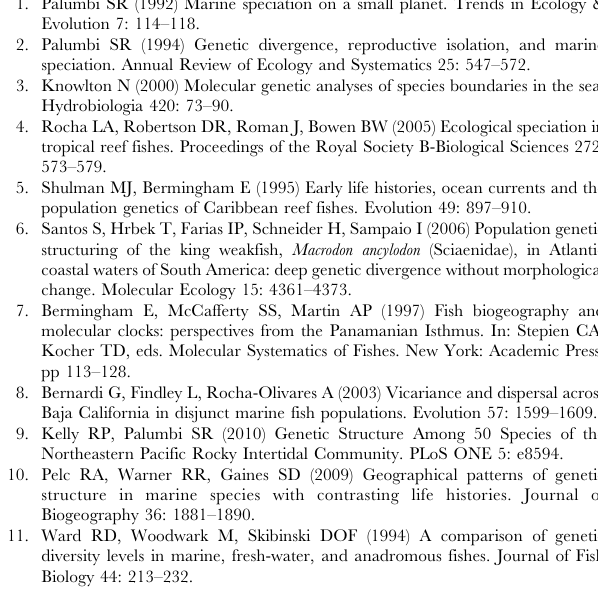
analyses of the Cathorops mapale group. Asterisk (*) indicate variables potentially associated with sexual dimorphism (Acero P. et al.,